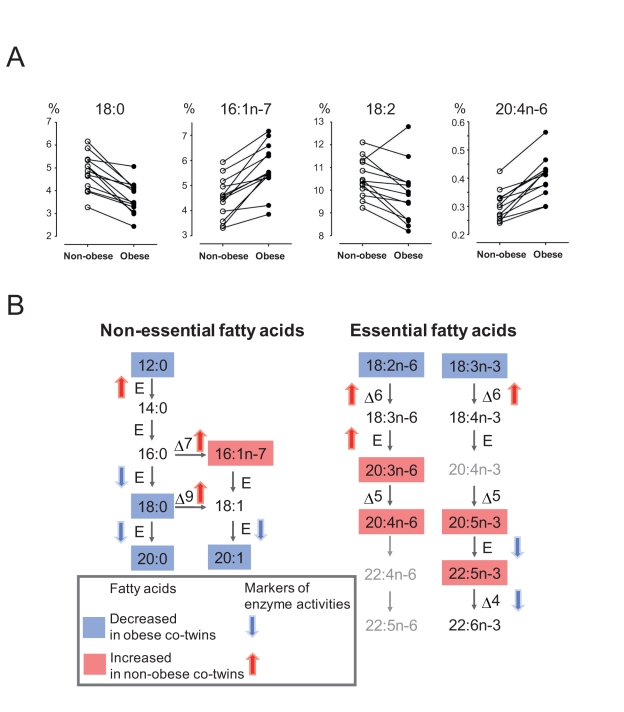
Fatty acid composition of adipose tissue in acquired obesity.Fatty acid profile was measured in adipose tissue biopsies in each of the
44 subjects. Complete results are shown in Table
S2. (A) Selected fatty acid relative amounts in 13 twin pairs
discordant for BMI. Lines connect the pairs of twins. (B) Schematic
representation of fatty acid compositional changes when comparing heavy
and lean obesity-discordant twins. Significant changes
(p<0.05; pairwise t test) are
color-coded. The activities of specific fatty acid elongation or
desaturation steps are estimated by appropriate fatty acid concentration
ratios.